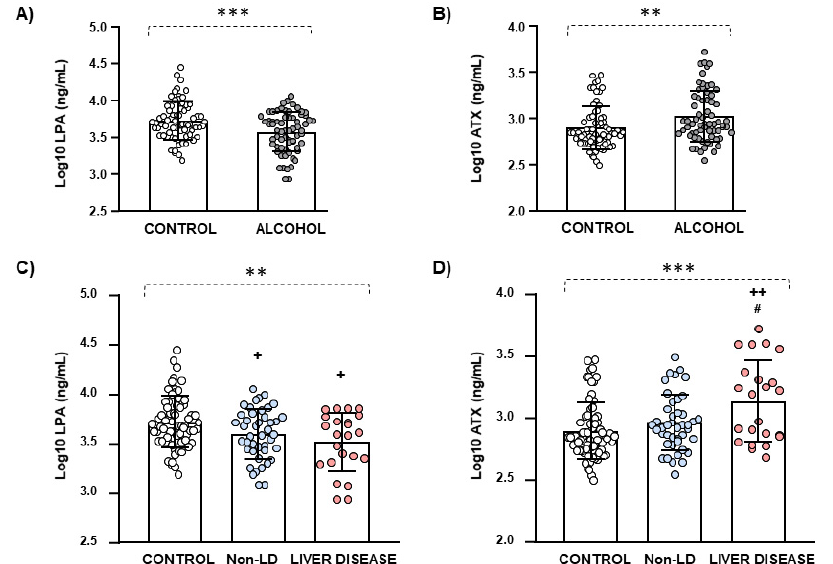
Figure 1. Plasma concentrations of LPA and ATX in the sample. ( A ) Log 10 -transformed concentrations of LPA in the control and alcohol groups; ( B ) Log 10 -transformed concentrations of ATX in the control and alcohol groups; ( C ) Log 10 -transformed concentrations of LPA in the control group, the non-liver disease (non-LD) subgroup, and the liver disease subgroup; and ( D ) Log 10 -transformed concentrations of ATX in the control group, the non-liver disease (non-LD) subgroup, and the liver disease subgroup. Lines and bars on the scatter plot are means and SD. Data were analyzed by ANCOVA while controlling for age, BMI, and sex as covariates. (***) p < 0.001 and (**) p < 0.01 denote significant main effects of the “group/subgroup” factor. ( + ) p < 0.05 and ( ++ ) p < 0.01 denote significant differences compared with the control group (post hoc test). ( # ) p < 0.05 denotes significant differences compared with the non-LD subgroup (post hoc